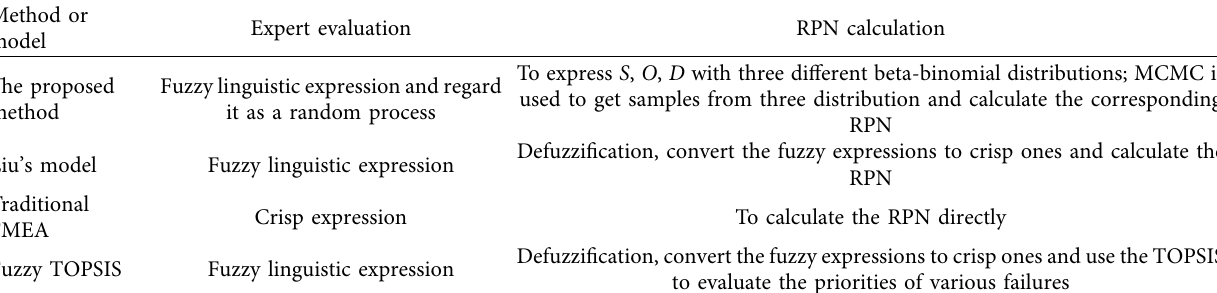
Table 5: The comparison between different methods.